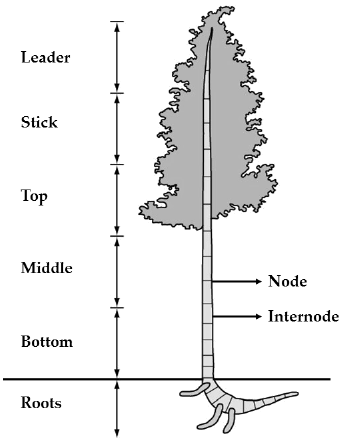
Figure 1. Parts of the culm of Guadua angustifolia Kunth. Table 1. Characteristics of the ordinary Portland cement (type I), used in the composite.